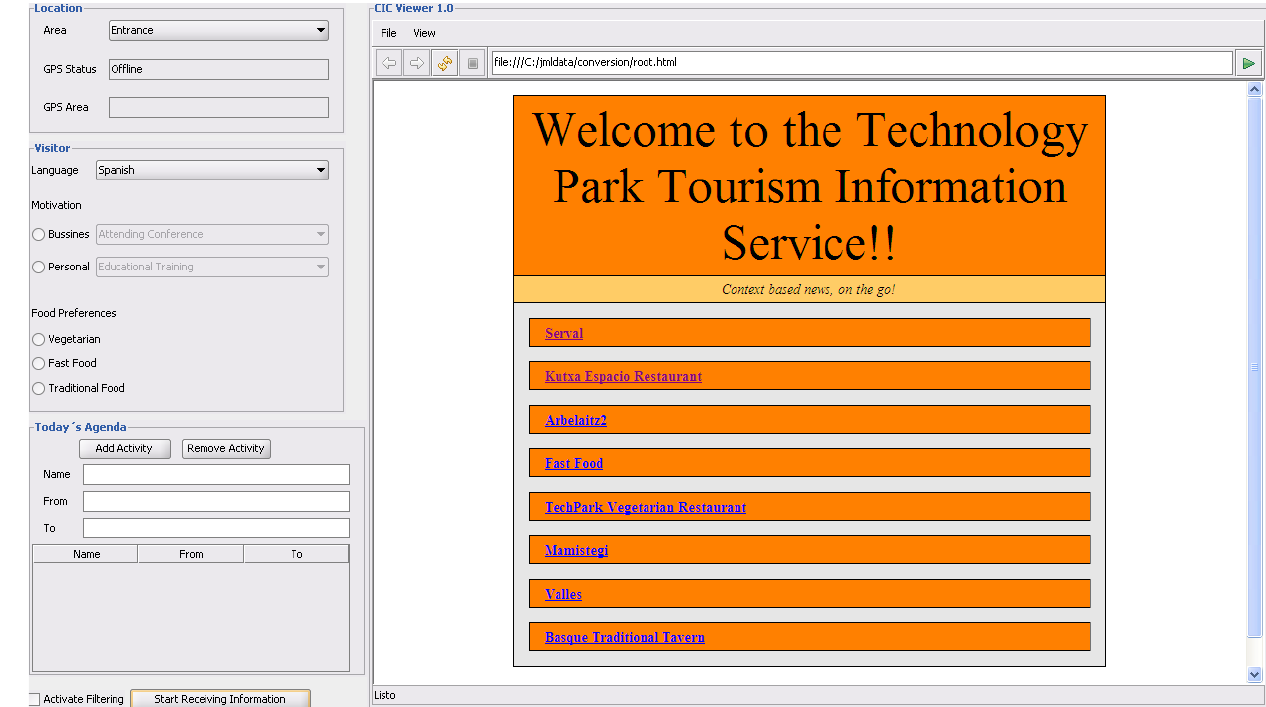
Figure 6. Display of the